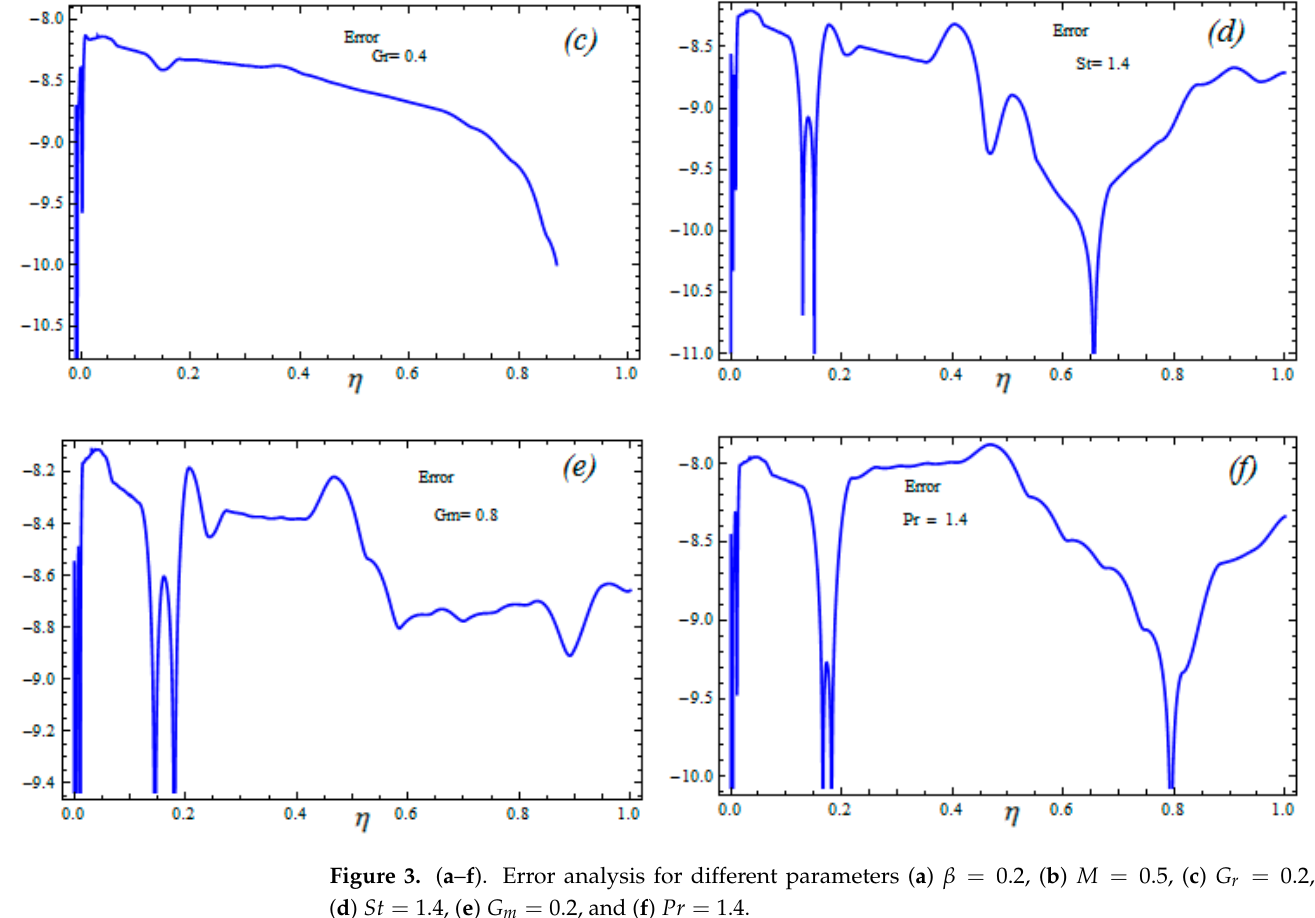
Figure 3. ( a – f ). Error analysis for different parameters ( a ) β = 0.2, ( b ) M = 0.5, ( c ) G r = 0.2, ( d ) St = 1.4, ( e ) G m = 0.2, and ( f ) Pr = 1.4.